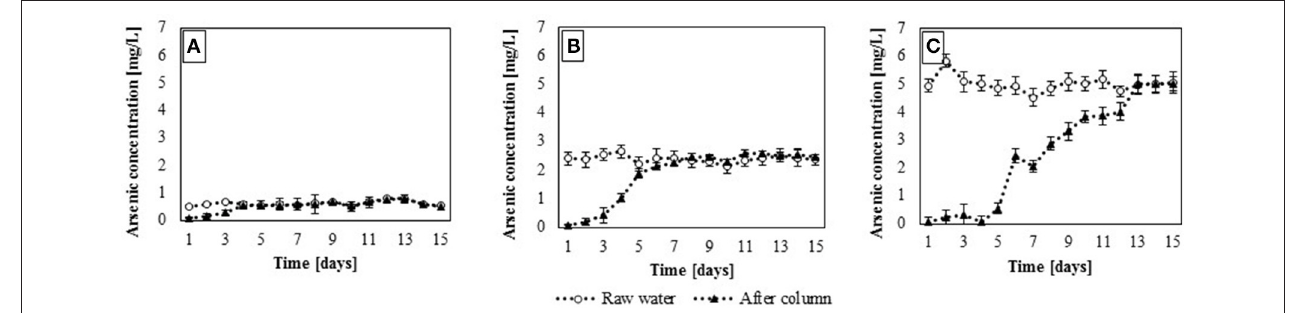
FIGURE 7 | Dynamic sorption efficiency with regard to arsenic in the contaminated waters: (A) , groundwater; (B) , surfacewater and (C) , sediment pond (mean ± SD, n = 2).